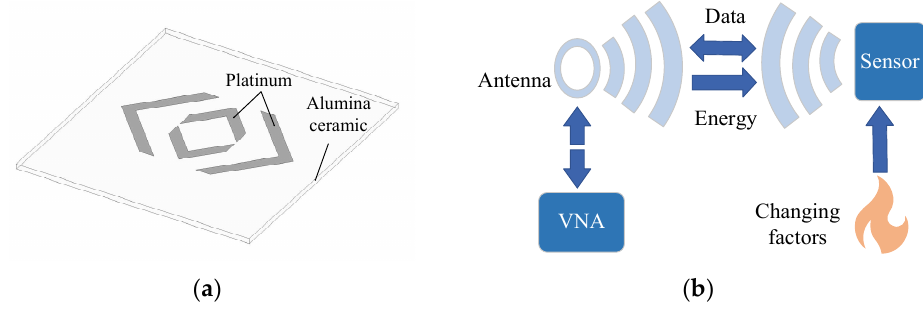
Figure 1. ( a ) Side view. ( b ) Working principle diagram.